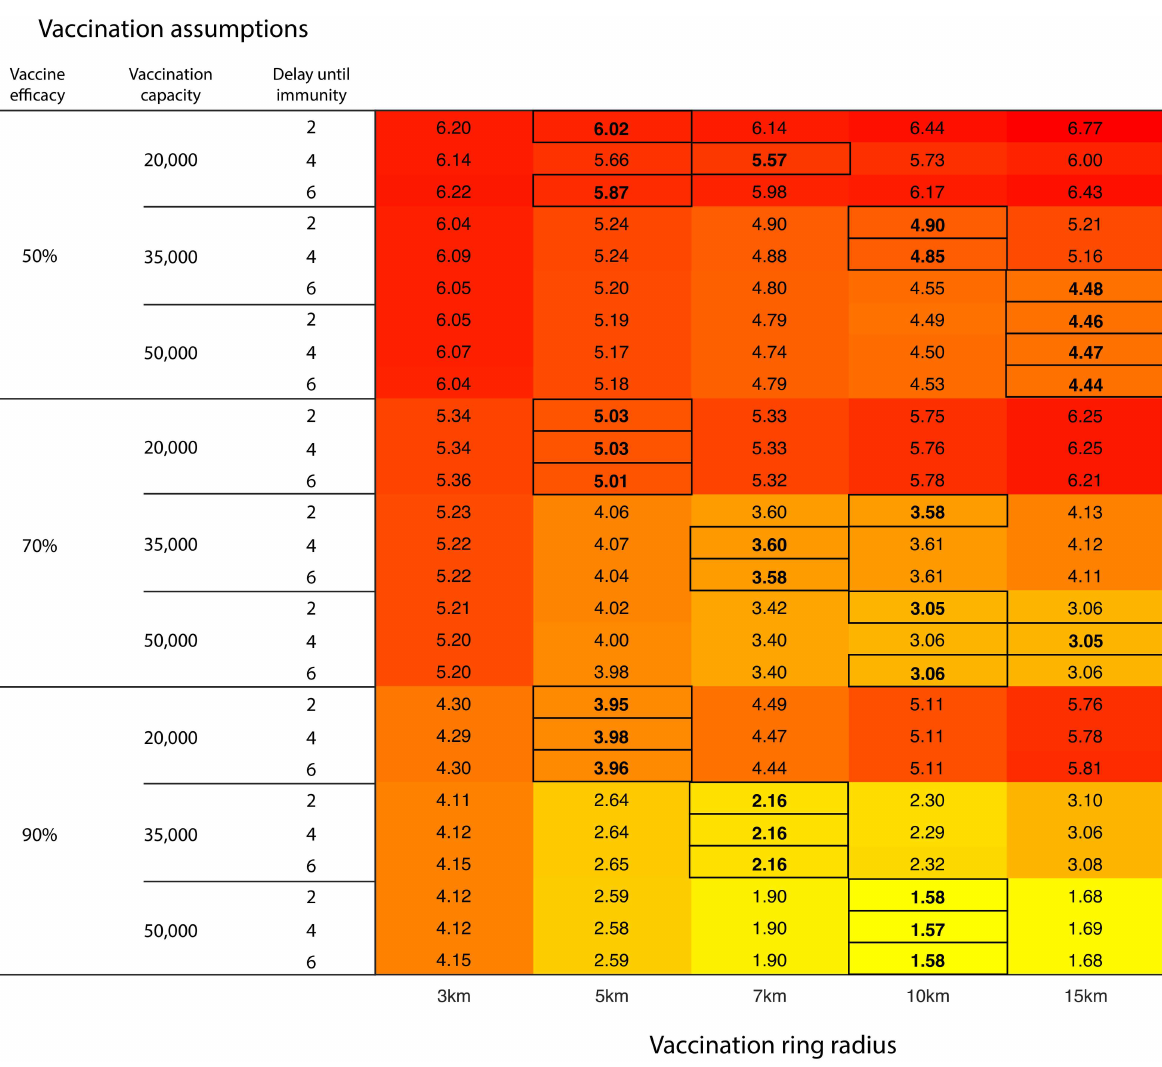
Fig 1. Projected mean livestock culled (million head) under various vaccination ring radii (columns) and vaccination parameterisations (rows). Rows represent different combinations of parameters regardingvaccination efficacy, vaccinationcapacity (number of animalsvaccinatedper day), and the delay (in days) from administering vaccinationand conferral of immunity. Results have been presented roundedto two decimalplaces with the optimalstrategy selectedprior to rounding.Outlinedvalues denote the optimal control action for a given set of vaccination